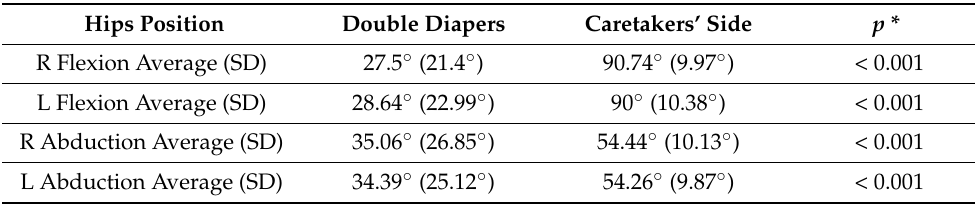
Table 2. Flexion and abduction degrees measurement of the right (R) and left (L) hip with standard deviation (SD) with double diapers and on the caretakers’